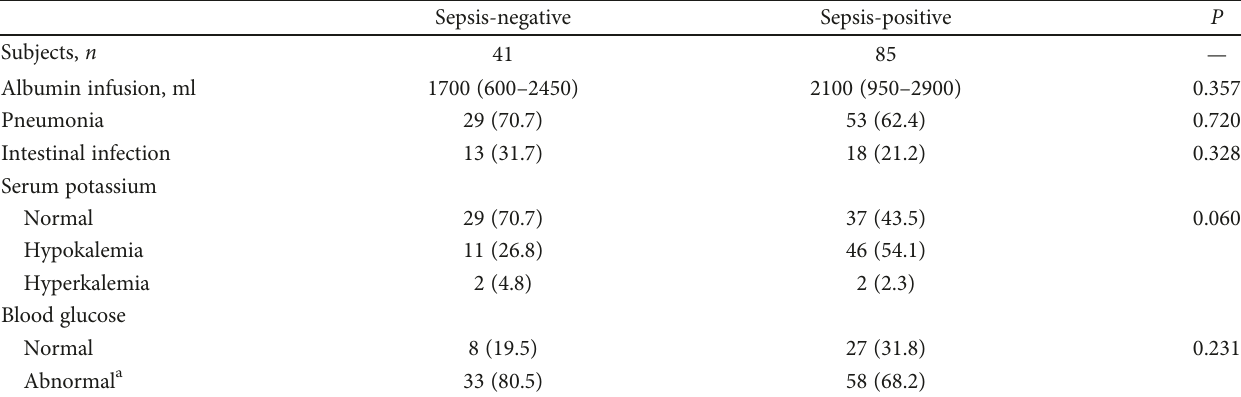
Table 6: Postoperative clinical characteristics of patients with or without orthotopic liver transplantation- (OLT-) related sepsis (reported as n (%), unless otherwise